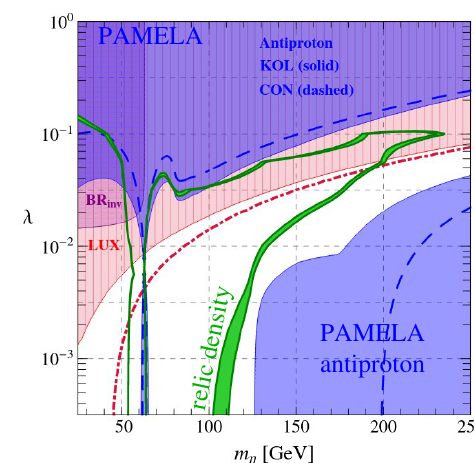
Figure 18: Combined relic density, direct and indirect detection constraints, again for the SO(6) → SO(5) model, from Ref. [ 113